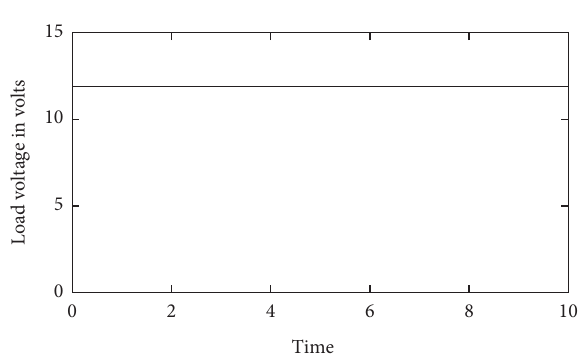
Figure 40: Terminal voltage at the node. Table 5: Verification of the neural network algorithm.